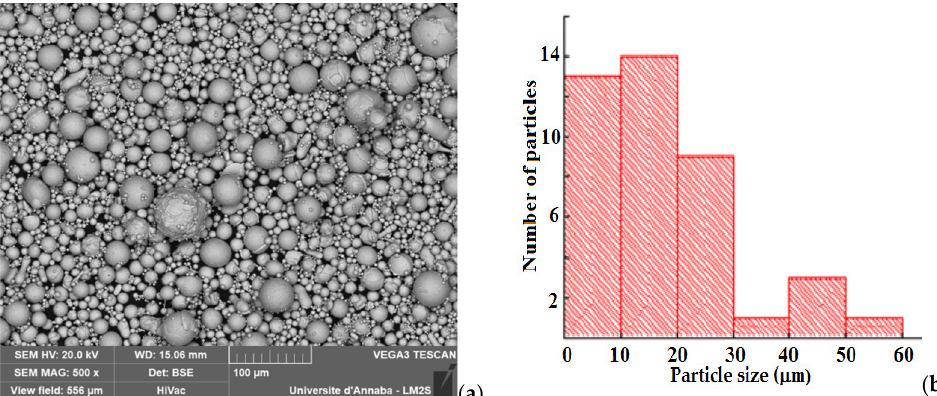
Figure 1. SEM micrograph ( a ) and particle size distribution ( b ) of the feedstock powders. Table 1. Elemental analysis of the initial powder. Element (at.%) ± Point